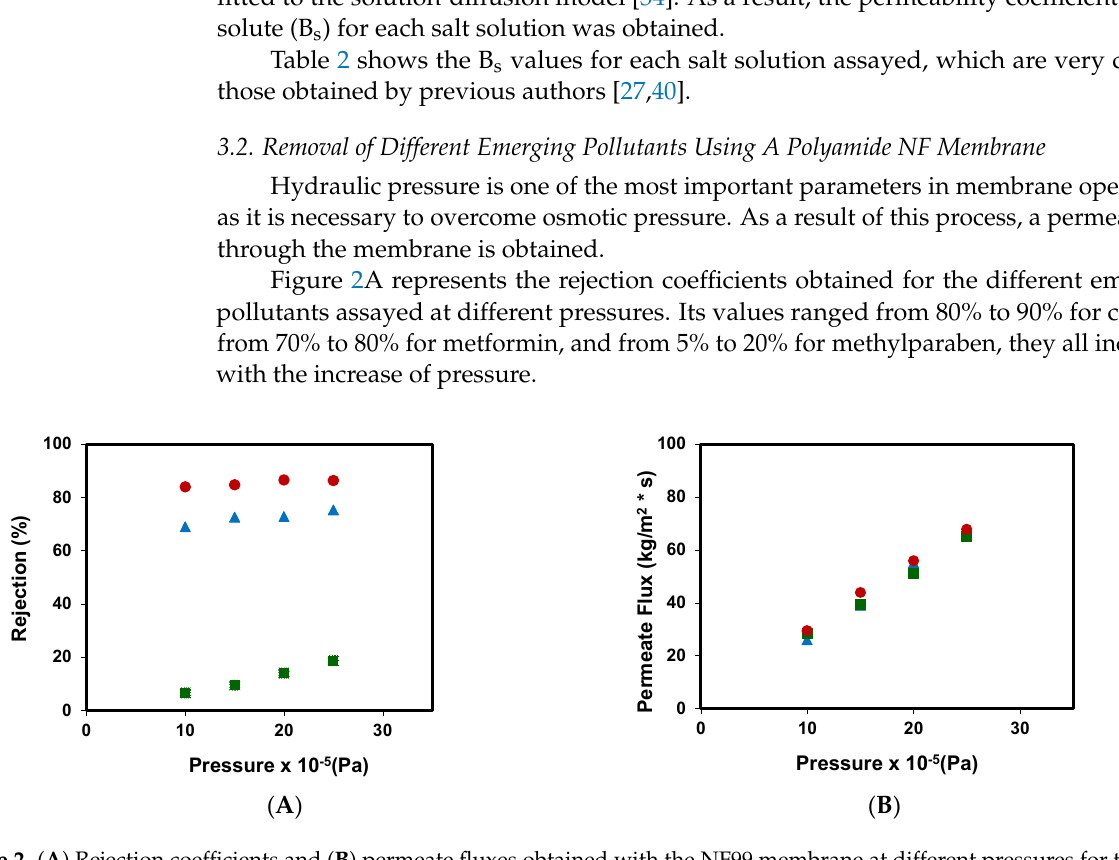
different emerging pollutants assayed: ( (cid:4) ) methyl paraben, ( • ) caffeine, and (